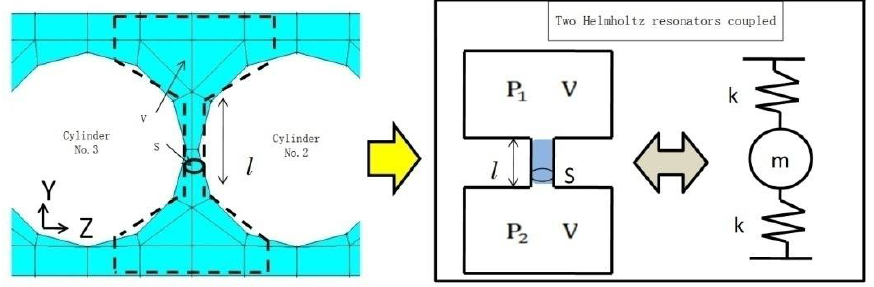
Figure 11. Simplifying the acoustic model between cylinders into a face-to-face Helmholtz coupler.